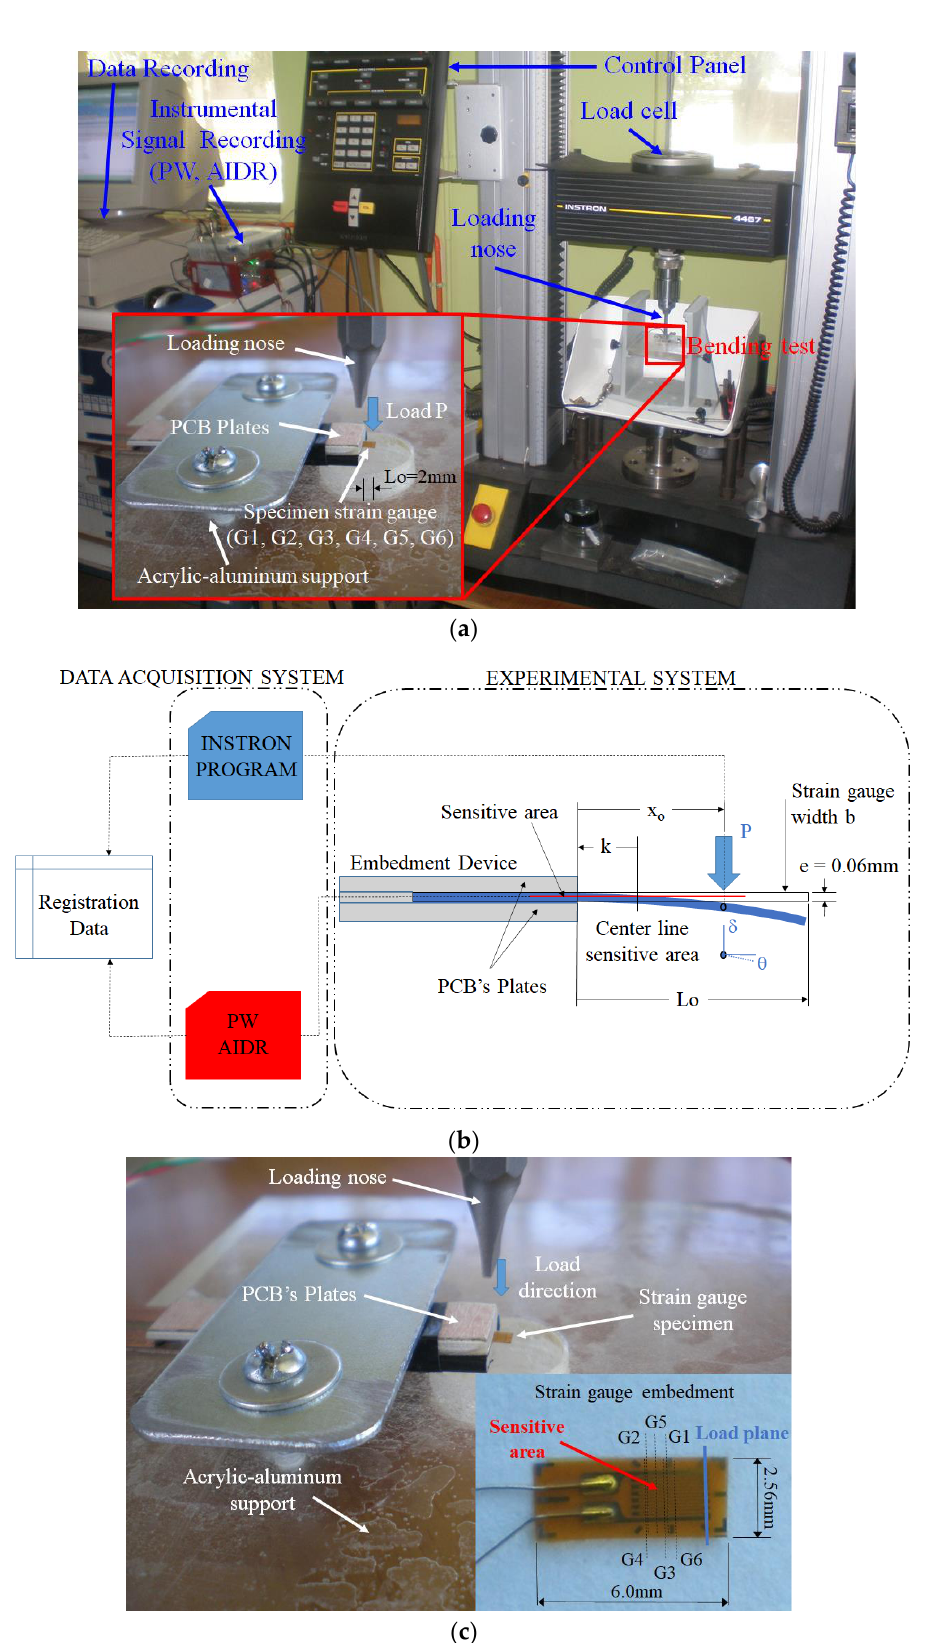
Figure 1. Proposed two-point bending test: ( a ) INSTRON and experimental setup for implementing the bending test (loading nose width 1.0 ± 0.05 mm), ( b ) scheme of the bending test and data recording, ( c ) details of the strain gauge embedment.